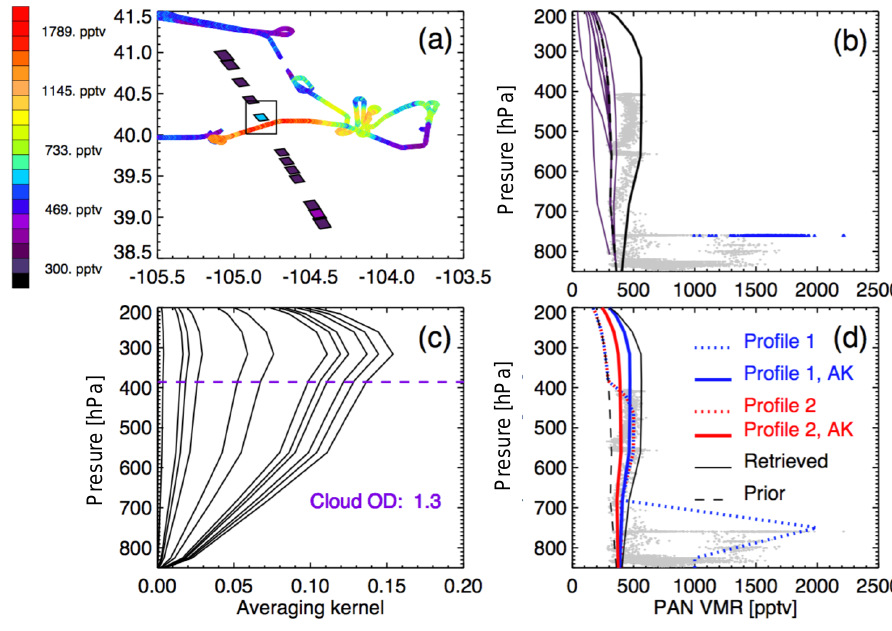
Figure 3. (a) Map showing FRAPPÉ aircraft and TES tropospheric average satellite observations of PAN over the Colorado Front Range on 29 July 2014. We define the tropospheric average for a given retrieval as the average retrieved PAN between 800hPa and the tropopause. TES data show elevated PAN near the location where the aircraft data show highest values for that day. (b) All aircraft observations for 29 July 2014 are shown in grey. Blue points show aircraft data within 0.1 ◦ longitude and 0.2 ◦ latitude of the most elevated TES PAN observation. TES retrieved PAN profiles for 29 July 2014 are also shown. The elevated case is shown by the solid black line, while other cases are shown in purple solid lines. The black dashed line shows the TES a priori profile used in these retrievals. (c) TES averaging kernels for this case. The retrieval indicates that a high cloud is present, with optical depth 1.3, leading to reduced sensitivity below the cloud. (d) The blue dotted line shows a profile constructed to approximate the aircraft measurements, where PAN is highly elevated in the lower atmosphere. The blue solid line shows this same profile after smoothing with the TES prior and averaging kernel matrix for this scene. The red dotted line shows a hypothetical profile with no enhancement below 680hPa, while the red solid line shows that same profile smoothed with the TES prior and averaging